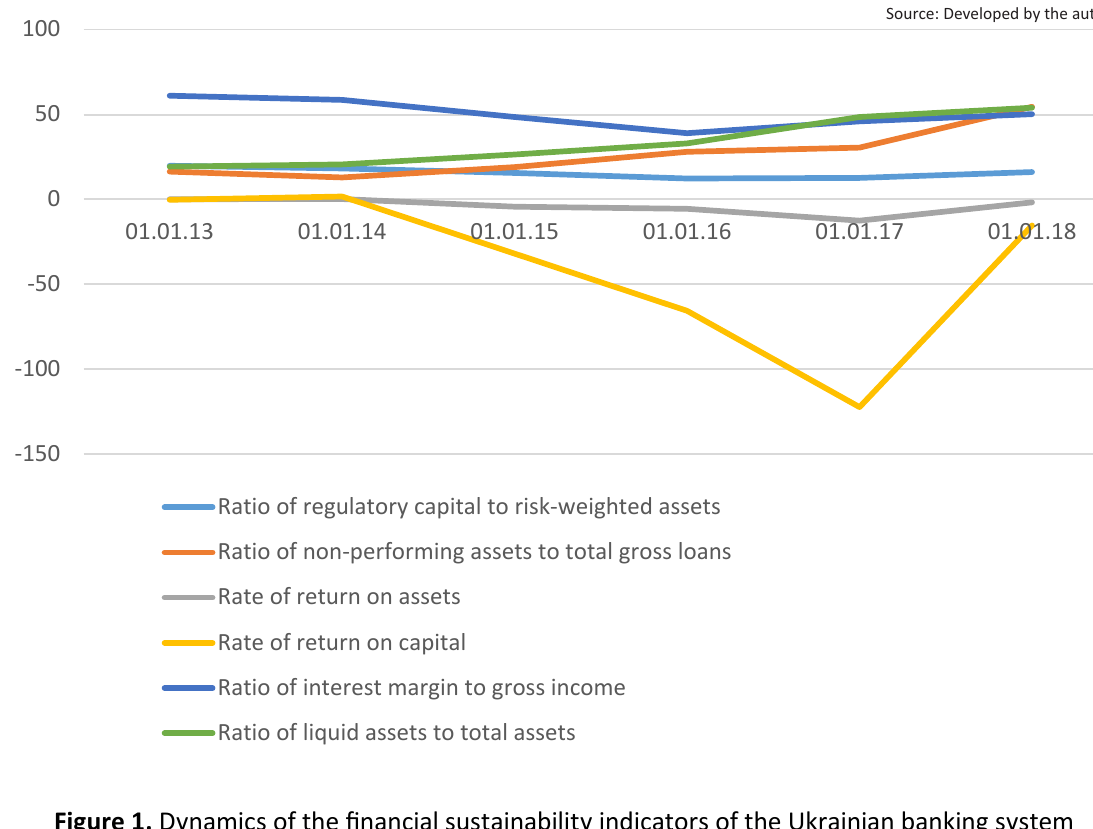
Figure 1. Dynamics of the financial sustainability indicators of the Ukrainian banking system for January 1, 2013 till January 1, 2018,